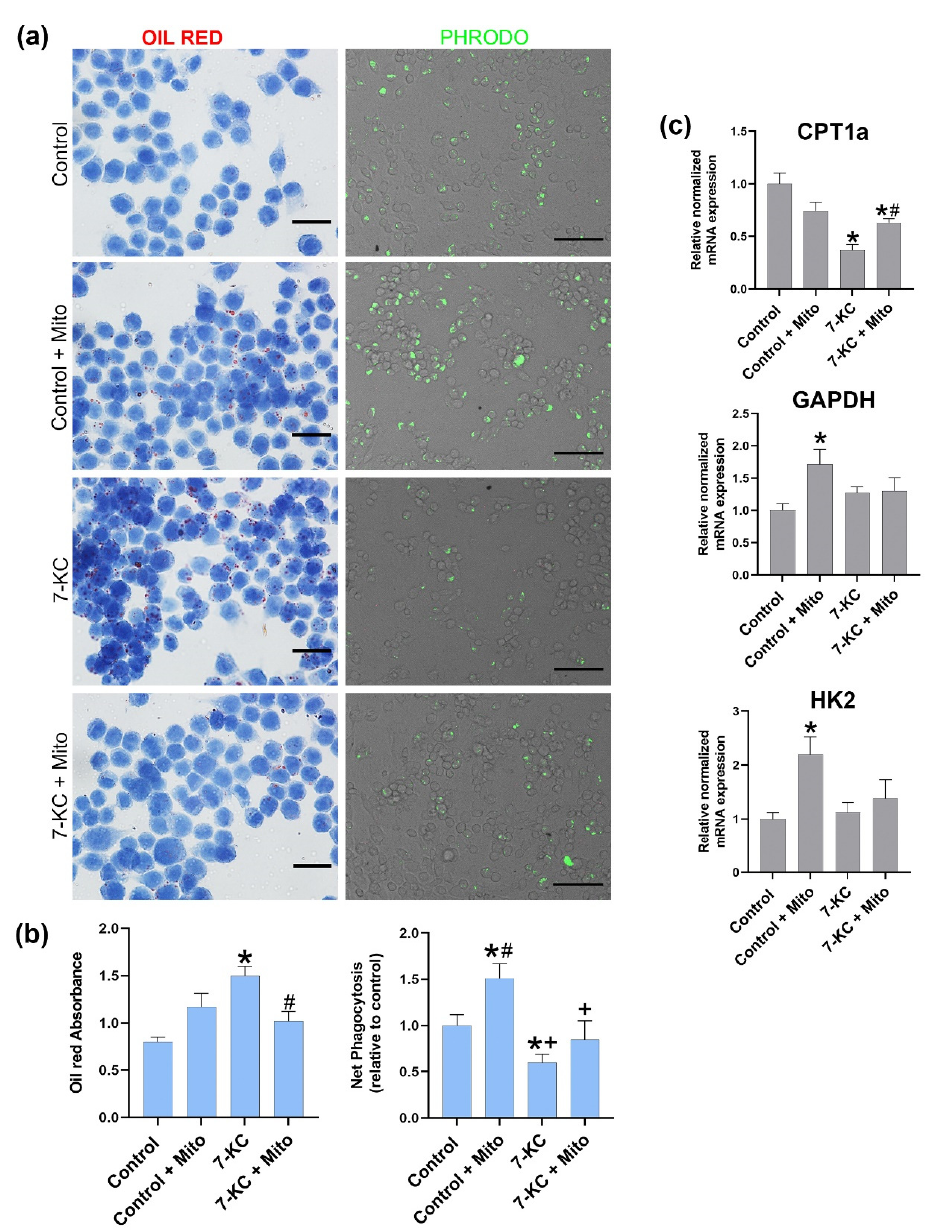
Figure 4. Effects of mitochondrial transfer on macrophage lipid content, mRNA expression CPT1a, GAPDH, HK2, and phagocytosis. RAW264.7 were incubated with 7-KC at 10 µ g/mL for 24 h. As a control, the cells were incubated with vehicle ethanol for 24 h. ( a ) Representative Oil Red O staining images, scale bar 20 µ m. Representative images of pHrodo uptake capture by fluorescence microscopy, scale bar 20 µ m.( b ) Oil red Absorbance at 510 nm and Net Phagocytosis of 55 µ g/mL pHrodo Green E. ecoli bioparticles conjugate for 90 min measured by spectrofluorometer at excitation 485 nm and emission 530 nm. ( c ) qPCR analysis of mRNA expression levels of CPT1a, HK2, and GAPDH represented relative to the control of the experiments. Data are represented as means ± SEM of 3 independent experiments with n = 3 each. p ≤ 0.05 * vs. control; # vs. 7-KC, + vs. control + mitochon- dria.